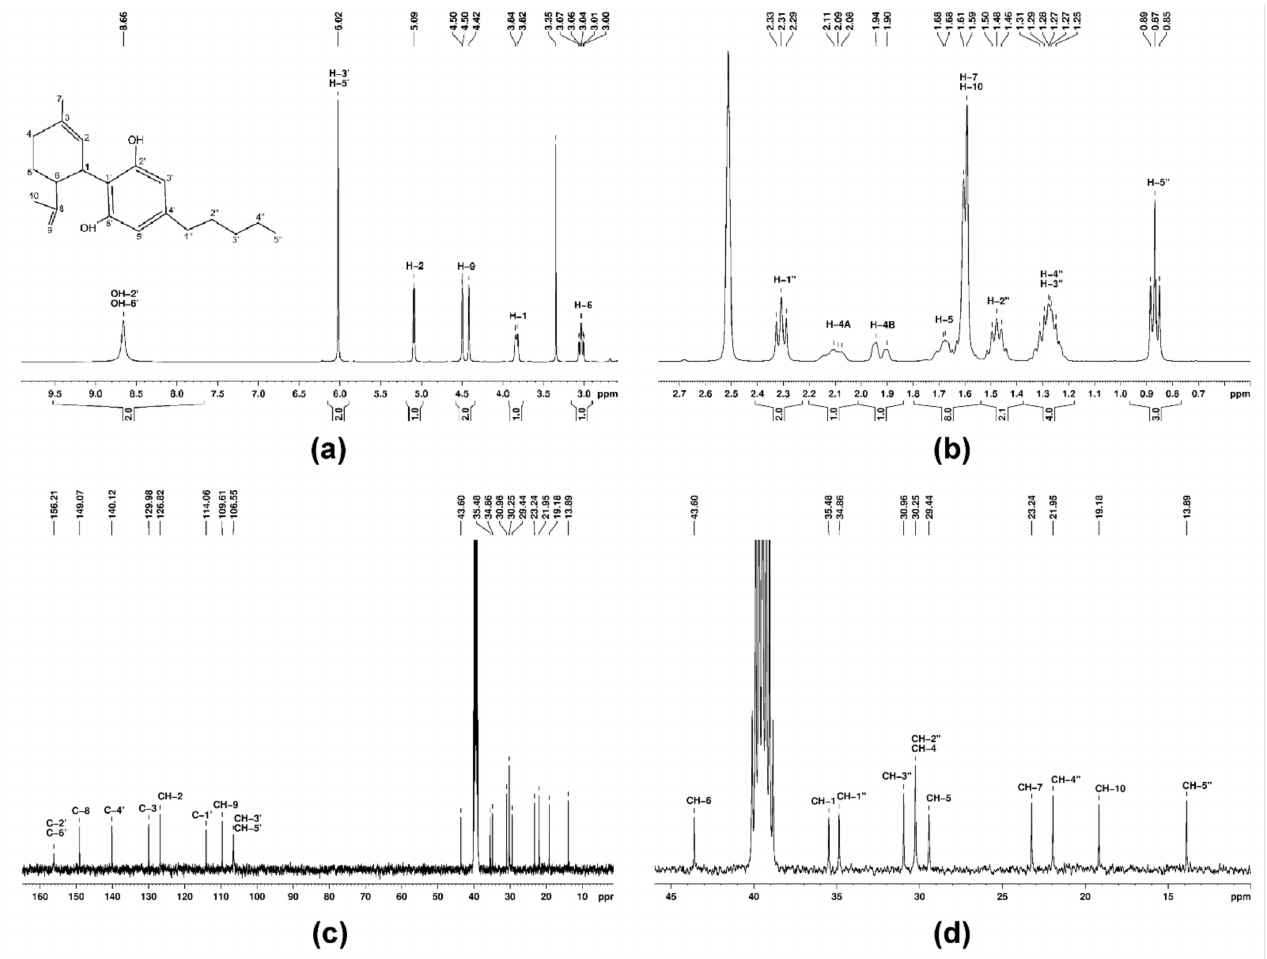
Figure 2. NMR spectra of pure CBD in DMSO-d 6 : ( a ) 1 H-NMR spectra in the range of δ 10–2.5 ppm; ( b ) 1 H-NMR spectra in the range of δ 2.8–0.5 ppm; ( c ) full 13 C-NMR spectra; ( d ) 13 C-NMR spectra in the range of δ 45–10